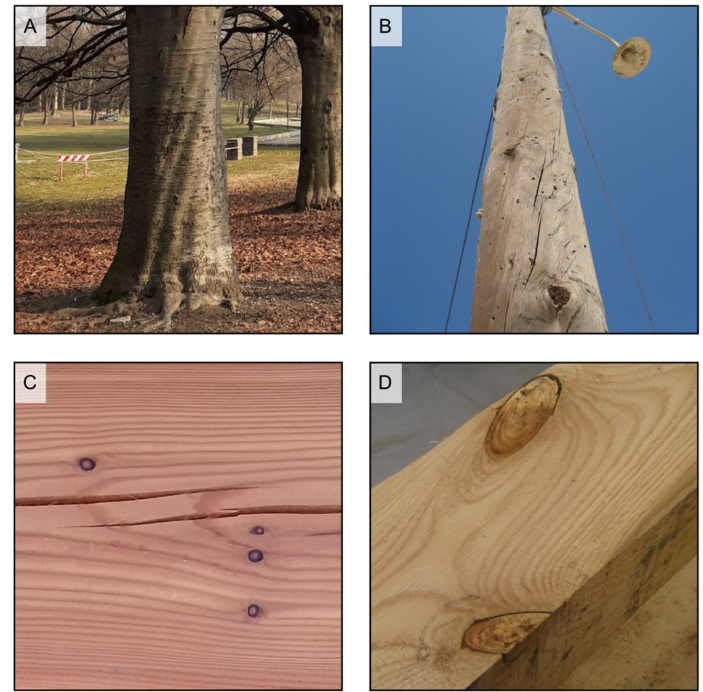
Figure 15. ( A ) spiral grain is visible in the tree in the foreground, while it is not present in that in the background ( Fagus sp.); ( B ) spiral grain in a softwood pole. Grain deviates around knots (( C ) small knots on Larix decidua ; ( D ) pair of knots on Castanea sativa ).